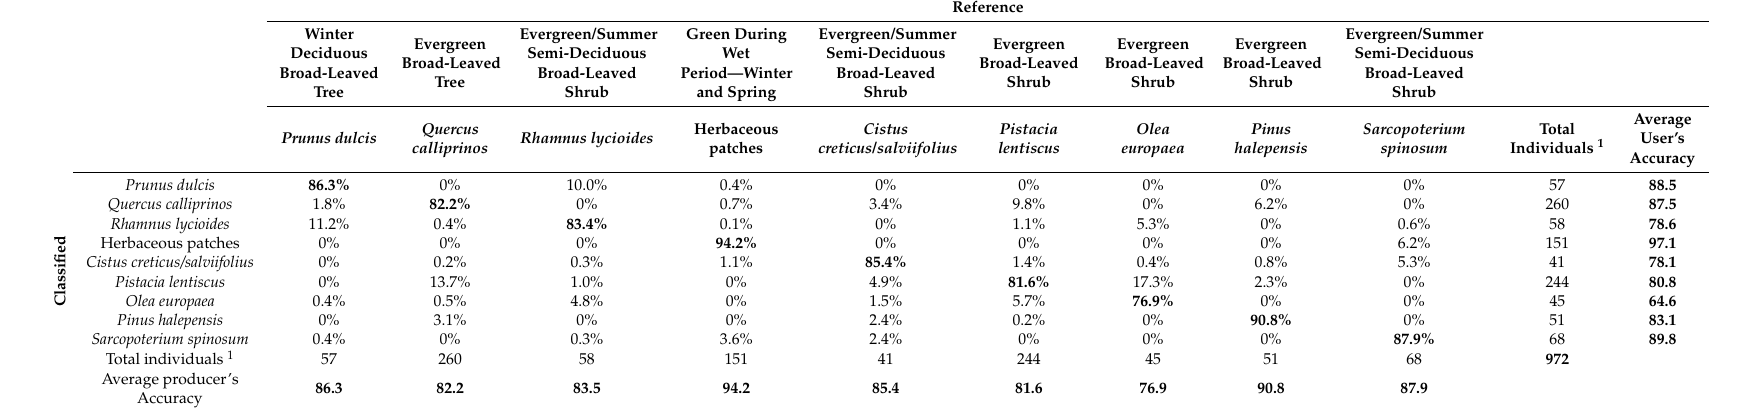
Table 5. Confusion matrix of the average results of ten subsequent cross-validation accuracy assessments of the UAV time series classification in the Mata site (M), based on RF classification of NDVI values from all five dates, together with the first seven PCA components of visible bands from all five dates. The distribution of classification success and error between species (matrix values) are displayed as the percentage of total